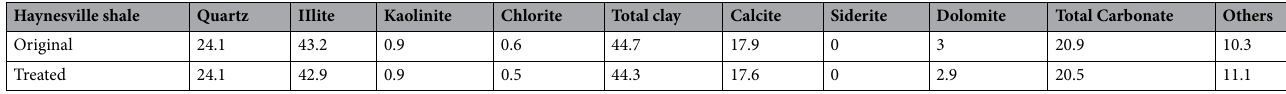
Table 1. Mineralogical comparisons (Vol.%).